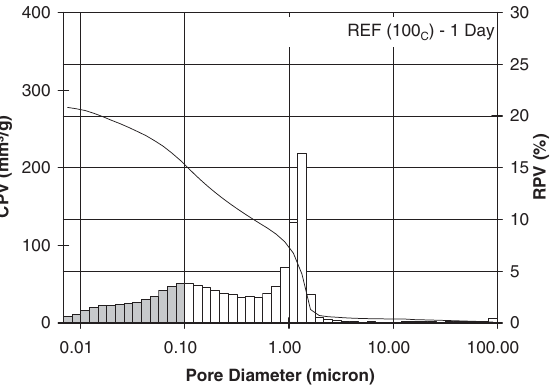
Fig. 4. Pore size distribution of paste P3